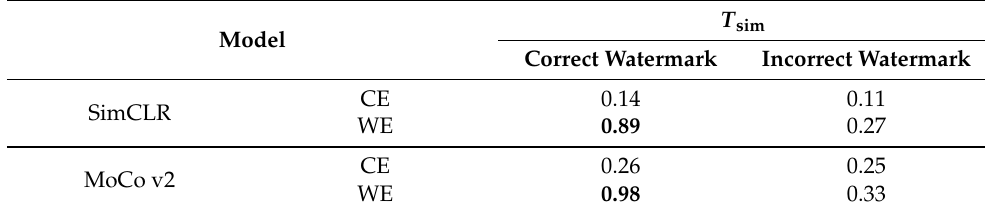
Table 2. Effectiveness evaluation under the white-box